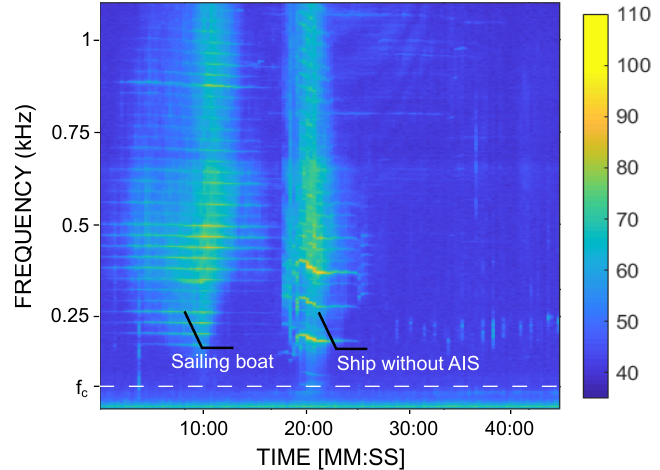
Figure 6. Spectrograms of two vessels recorded in Moonsund during the summer period. The dashed line shows the estimated cutoff frequency f c = 60 Hz below which ship-radiated sound does not propagate. The first vessel is an AIS-equipped sailing boat and the second is an unknown boat without AIS transmissions.